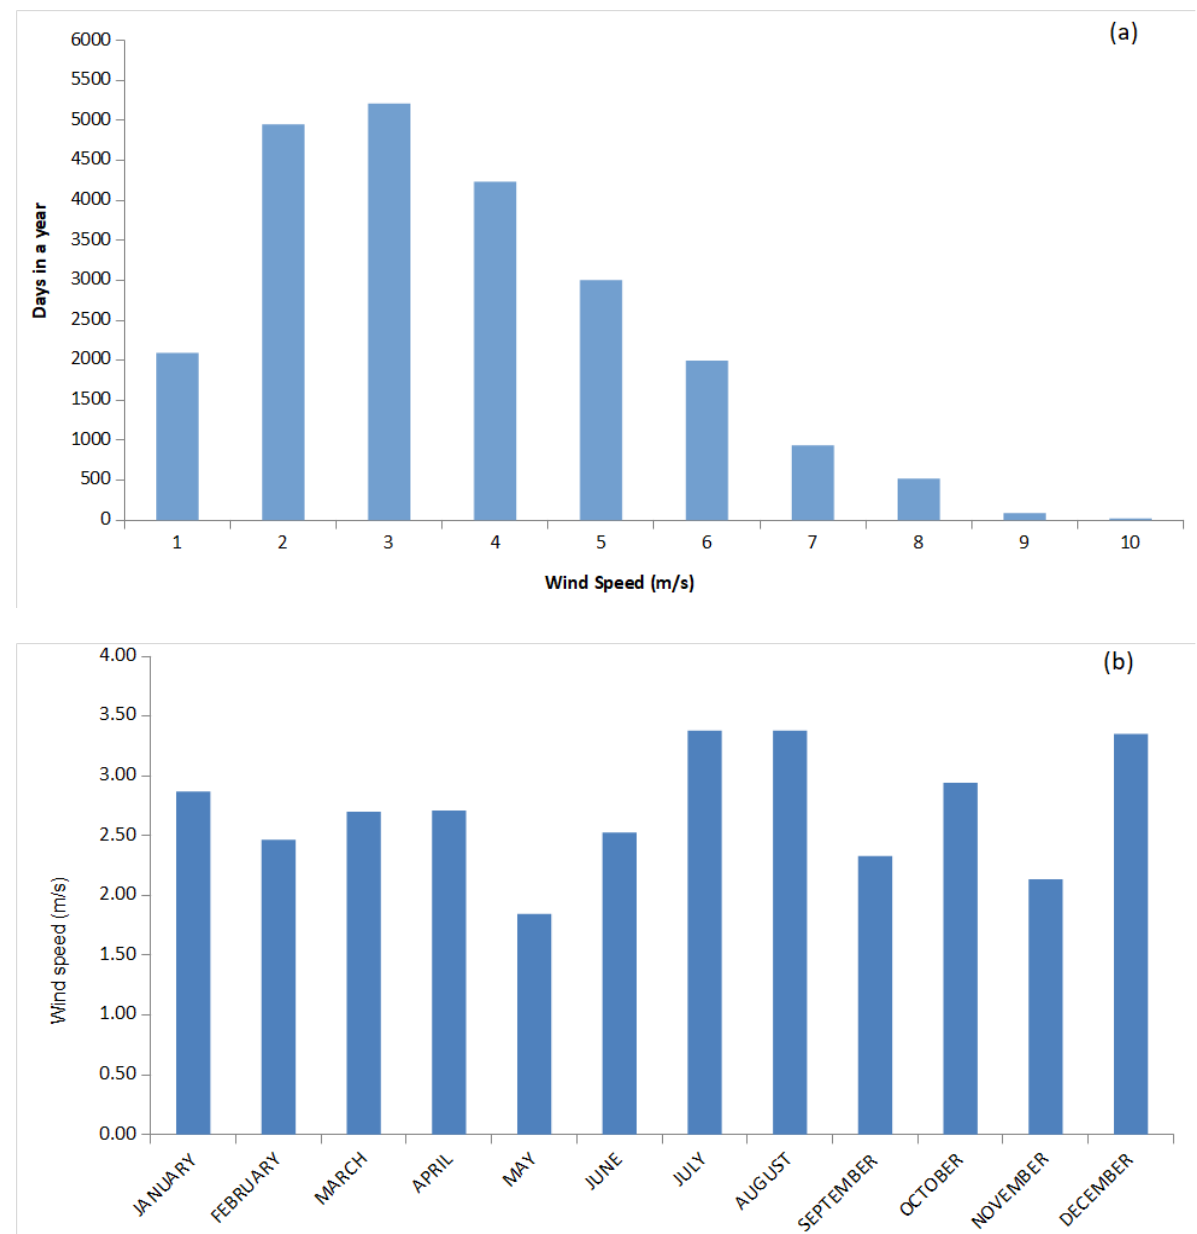
Figure 3. ( a ) Histogram of wind speed (m/s) vs. days of year and ( b ) average monthly wind speed (m/s) used in the case study.